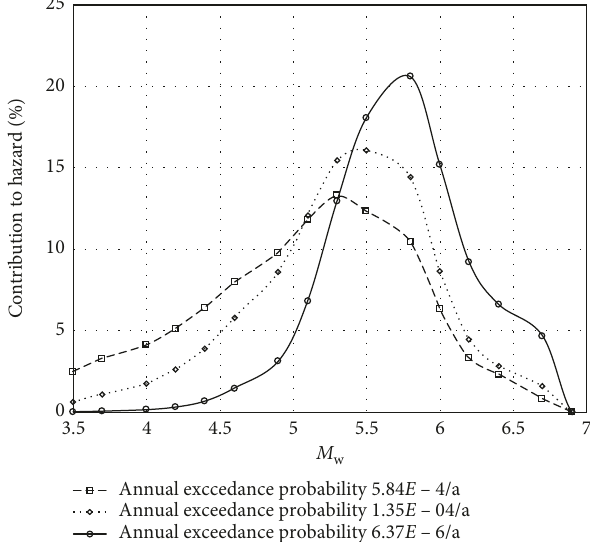
Figure 3: Contribution of magnitudes to the hazard at 5.84 E − 04/a, 1.35 E − 04/a, and 6.3 E 7 − 06/a levels.